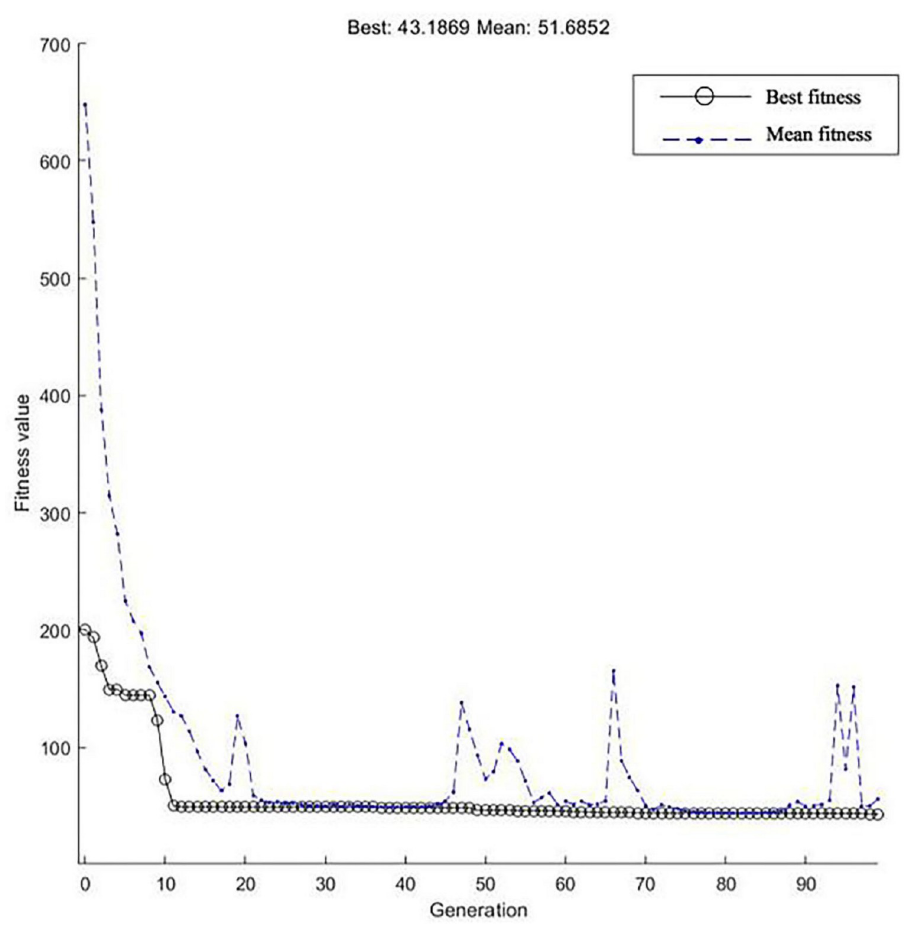
Fig 15. Genetic algorithms performance index optimization